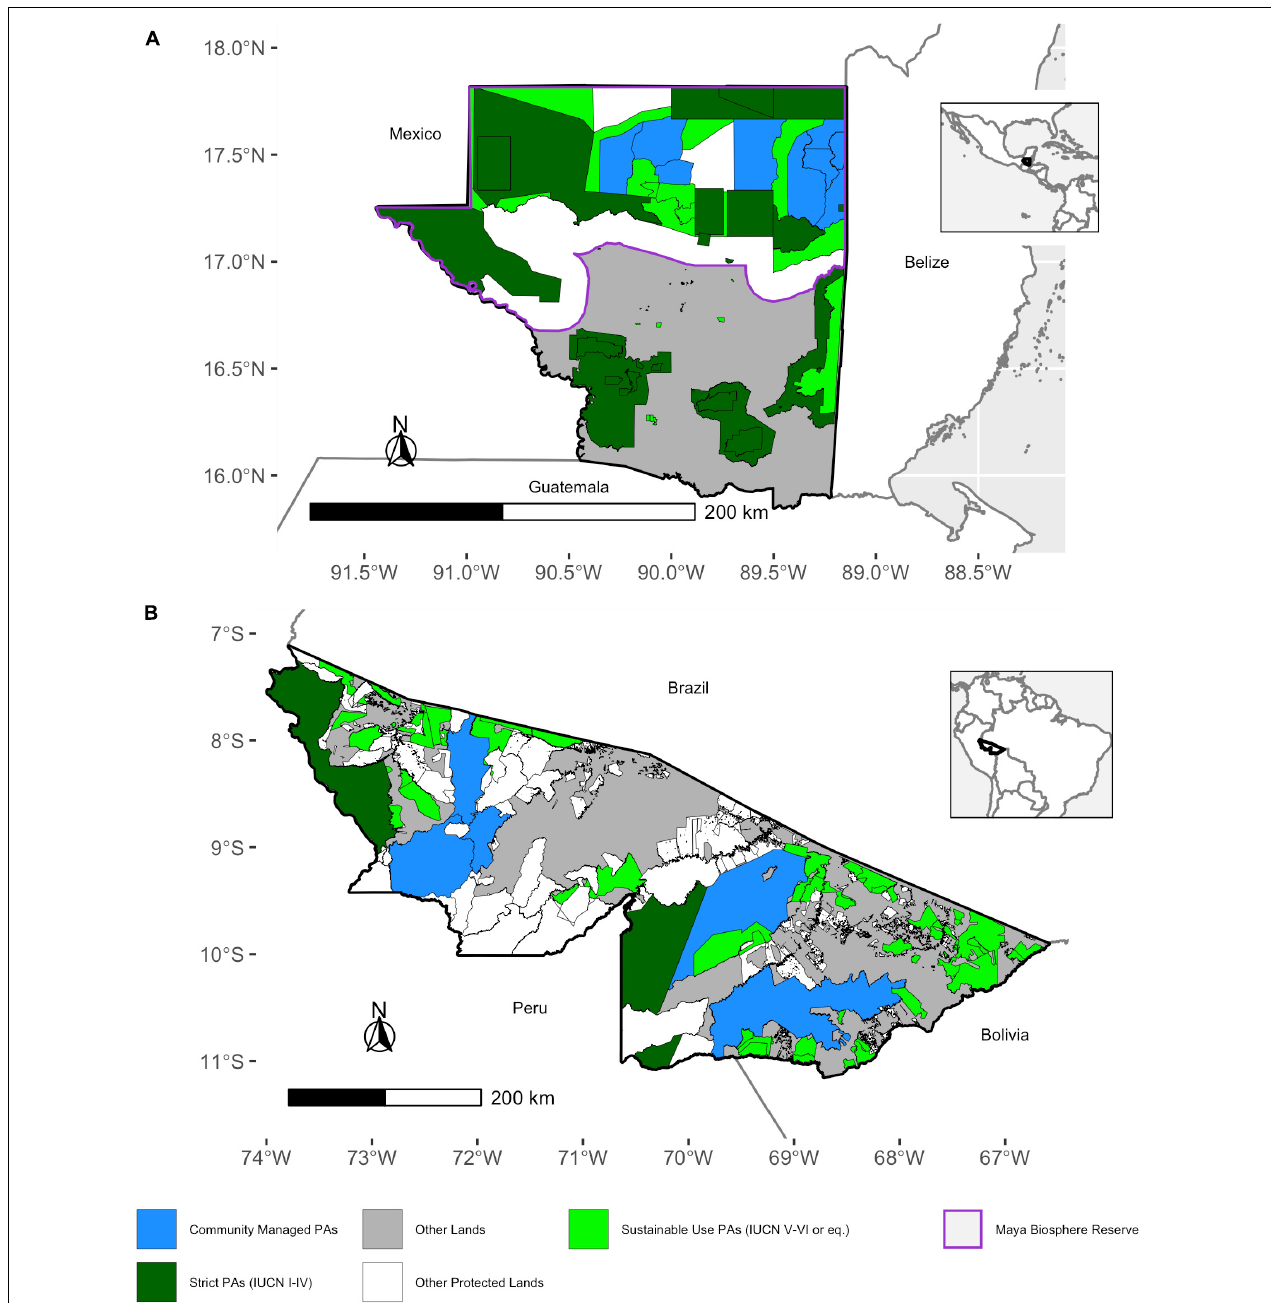
FIGURE 1 | Study areas. (A) The department of Petén in Guatemala (Central America). (B) The state of Acre in Brazil (South America). Land tenure is classified as Community Managed PAs (blue), which correspond to Community Concessions in Petén and Extractive Reserves in Acre, Other Lands (gray), Sustainable Use PAs (light green), Strict PAs (dark green), and Other Protected Lands